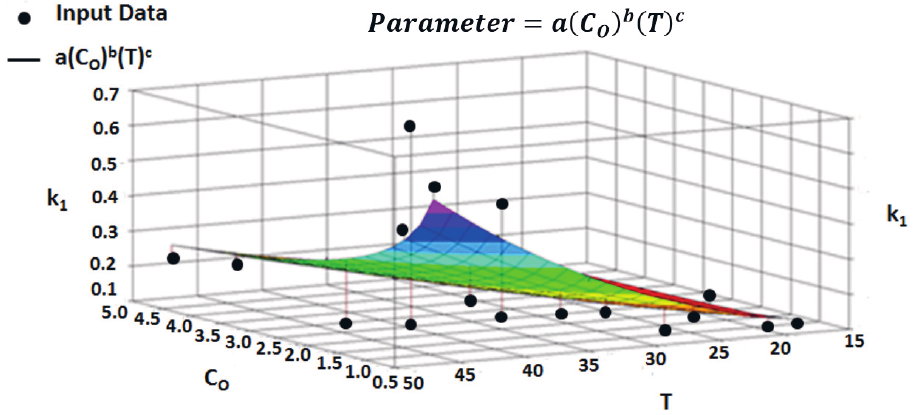
Figure 5. Multivariate function resulting from regression for chlorine parameter (cid:2193)